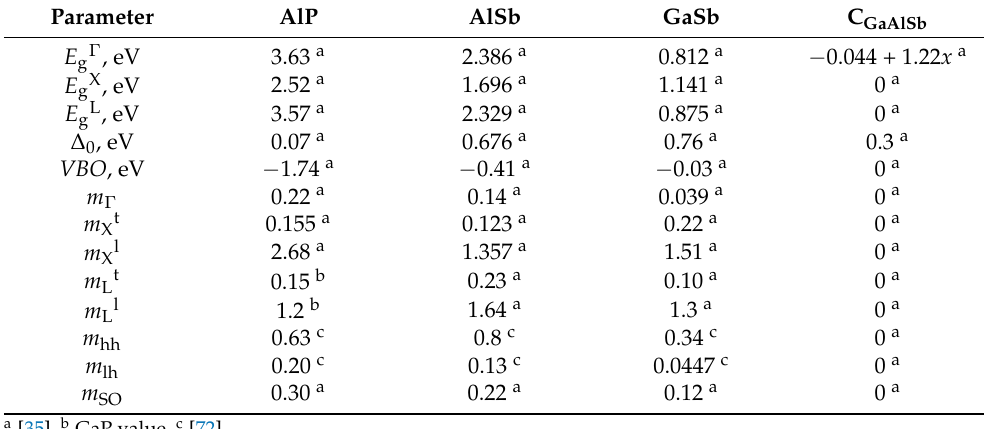
Table 2. Material parameters for AlP, AlSb, GaSb, and the bowing parameter for Ga x Al 1 − x Sb at 5 K, which were used for the calculations. E g Г ,X,L —bandgaps for Г -, X-, and L-valleys; ∆ 0 —spin-orbital splitting energy in the valence band; VBO —valence band offsets; m Г —effective electron mass in the Г -point of the Brillouin zone; m Xt and m Xl —transversal and longitudinal effective electron mass in the X-point of the Brillouin zone; m Lt and m Ll —transversal and longitudinal effective electron mass in the L-point of the Brillouin zone; m hh , m lh , and m SO —effective masses for heavy, light, and spin-orbital splitting holes, respectively.